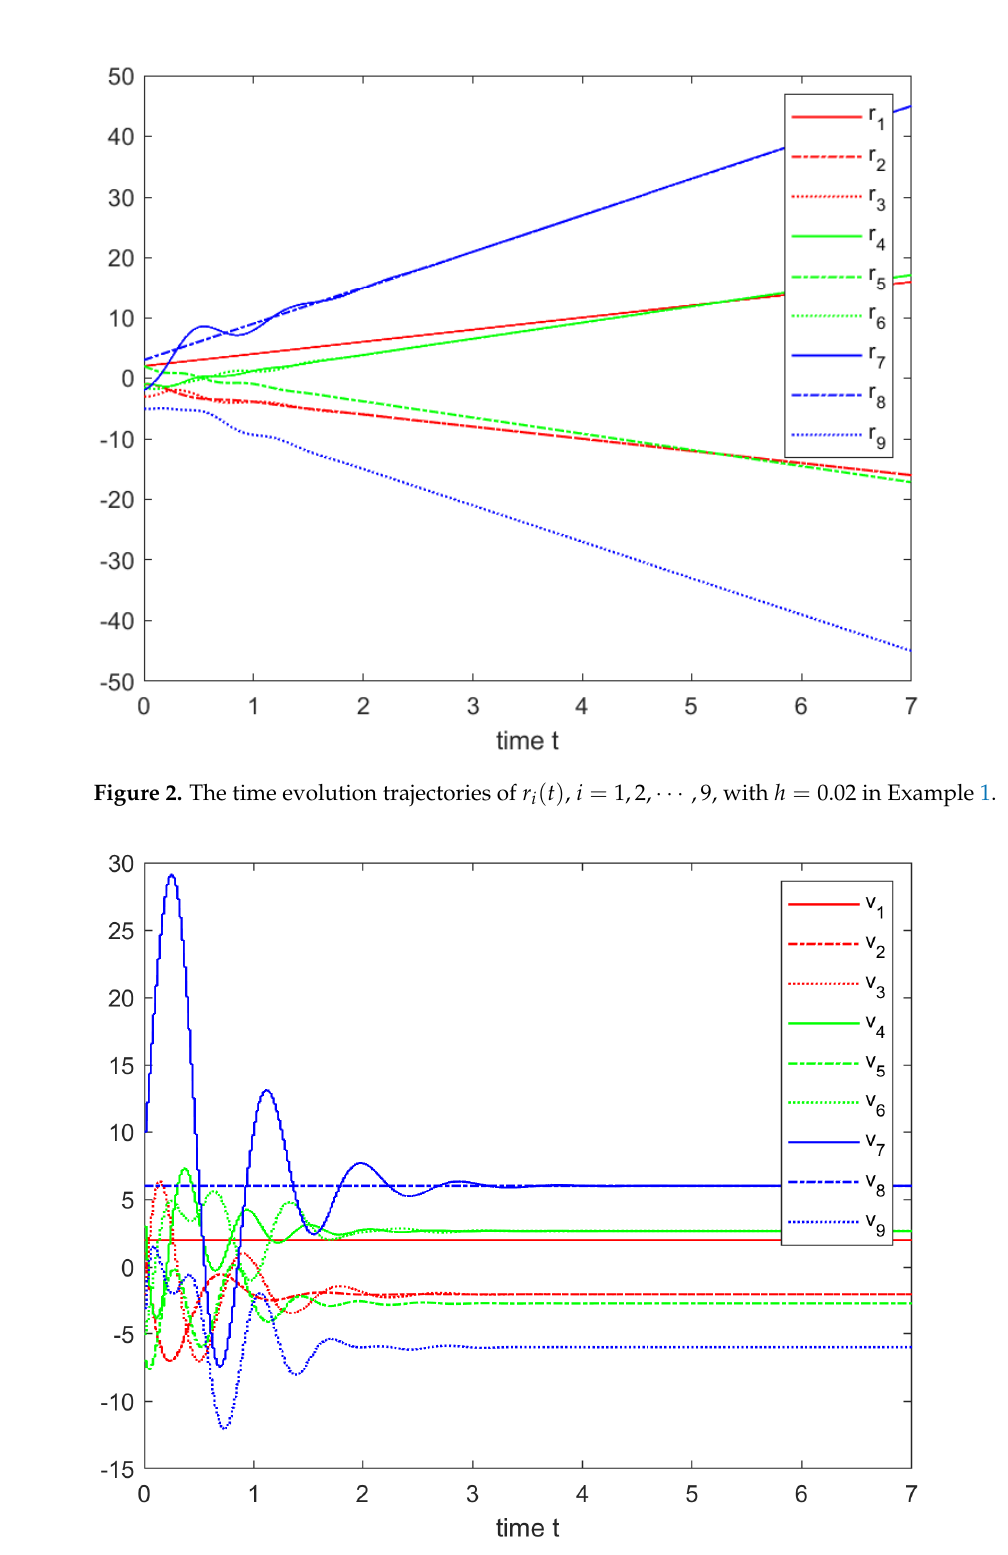
Figure 3. The time evolution trajectories of v i ( t ) , i = 1,2, · · · ,9, with h = 0.02 in Example